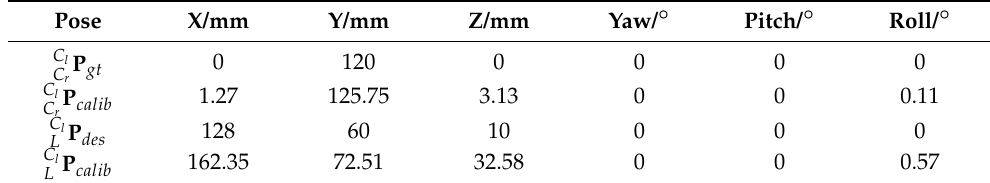
Figure 9. Comparison with the methods of Kwak and Huang. ( a ) Mean of translational errors. ( b ) Mean of rotation errors. Table 3. Calibration